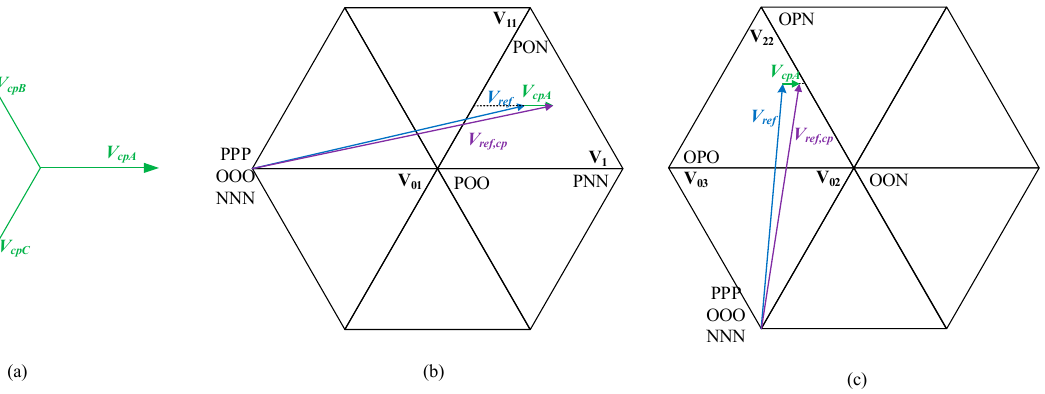
Figure 14. ( a ) Three compensation vectors for phase A,B,C; ( b ) V ref compensation when phase A is clamped to positive bus voltage; ( c ) V ref compensation when phase A is clamped to bus neutral point